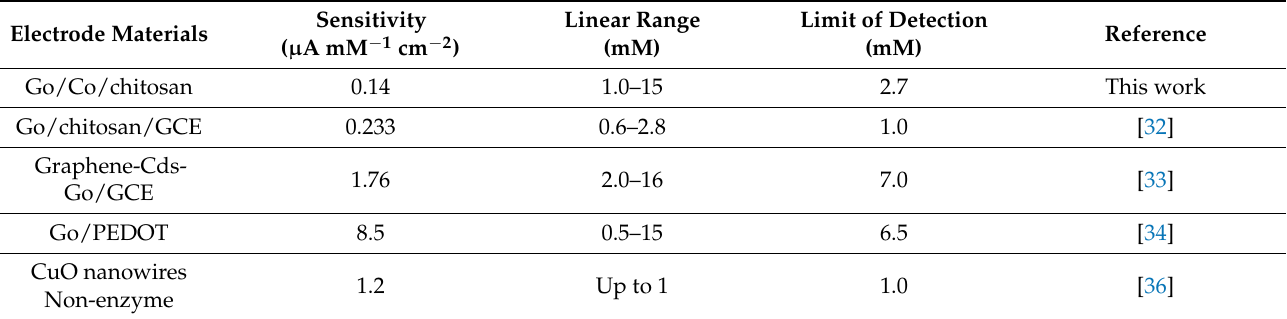
Table 1. Comparison of sensor properties among various electrochemical biosensors with the modi- fied electrode with glucose oxidase (Go)/electron transfer